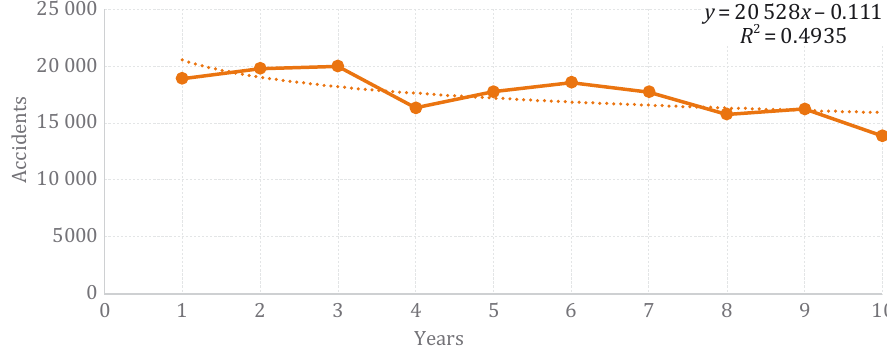
Figure 9. Number of accidents for the period of 2011–2020 associated with a power